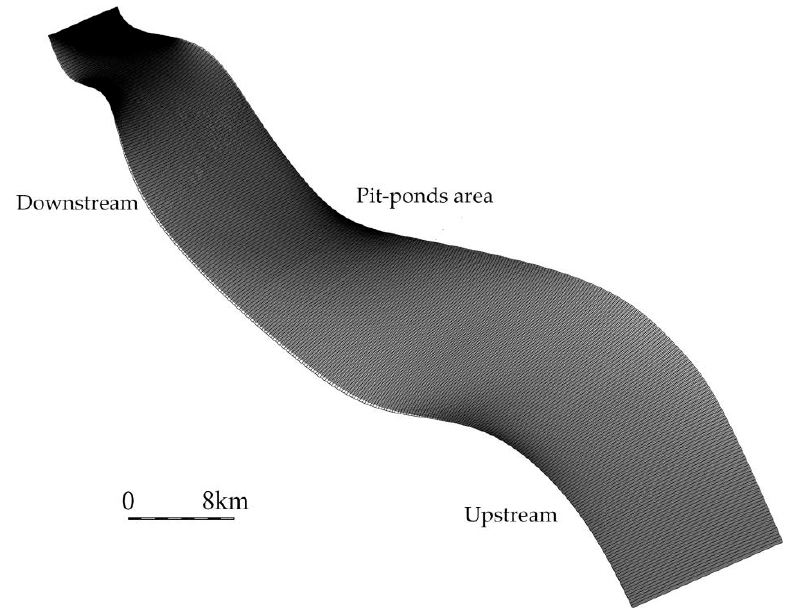
Figure 1. Grid diagram of the river section.